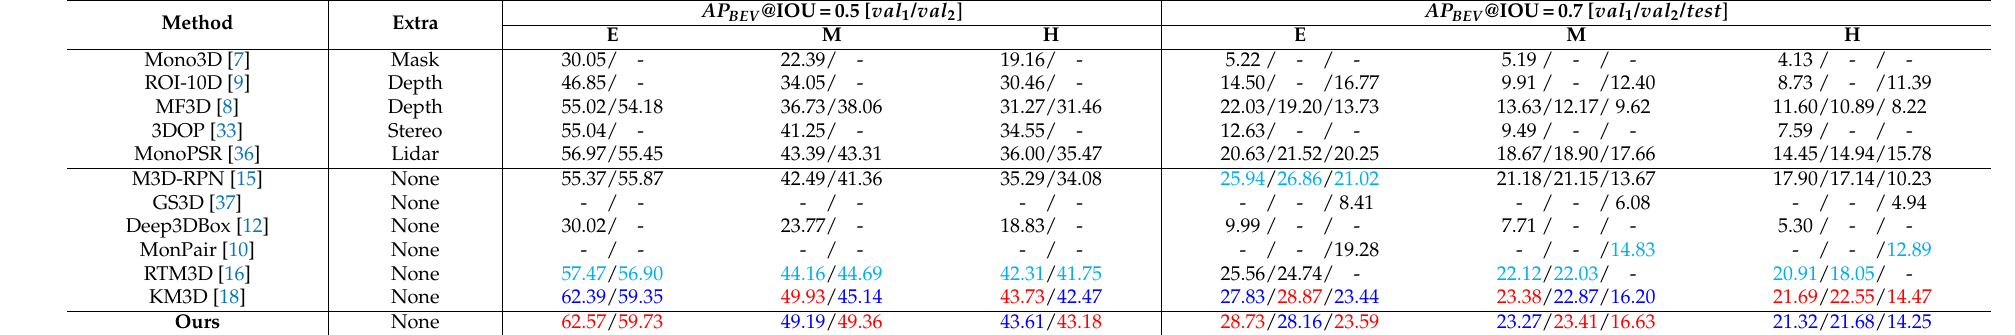
Table 2. AP BEV comparison on val 1 , val 2 and test with a 0.5 and 0.7 IOU threshold: (a) Extra indicates whether there is additional information to assist detection (b) E, M and, H indicate the levels from Easy, Moderate, to Hard. (c) The red, blue, and cyan denote the highest, second highest, and third highest results